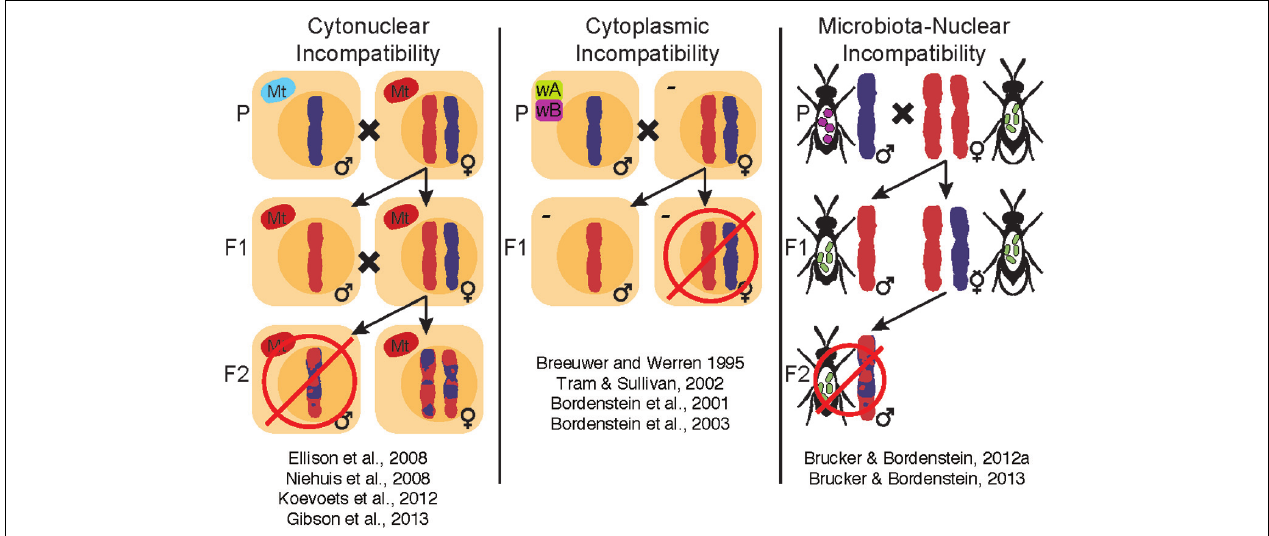
FIGURE 2 | Within the Nasonia clade, there are three published sources of hybrid incompatibilities: cytonuclear, cytoplasmic, and microbiota-nuclear incompatibilities. Cytonuclear incompatibilities, or negative interactions between mitochondria and the nuclear genome, are associated with lethality in F 2 males from younger interspecific crosses ( N. giraulti and N. longicornis ) and near complete lethality in older interspecific crosses ( N. vitripennis and N. giraulti or N. longicornis ). Hybrid lethality has some plasticity due to environmental factors (Koevoets et al., 2012), but clear cytonuclear incompatibilities that complicate development and gene regulation (Ellison et al., 2008; Niehuis et al., 2008; Koevoets et al., 2012; Gibson et al., 2013) have been genetically mapped across the Nasonia genomes. Cytoplasmic incompatibilities are a consequence of infection with different Wolbachia strains ( wA and wB ), which causes post-fertilization chromatin defects that result in inviable fertilized eggs (Bordenstein et al., 2001, 2003; Tram and Sullivan, 2002). Finally, microbiota-nuclear incompatibilities result from negative interactions between the microbiota and host genome and lead to hybrid lethality, altered microbial communities and innate immune regulation (Brucker and Bordenstein, 2013). The collective influences of these incompatibilities on Nasonia make it a powerful model for evolutionary and symbiotic studies of speciation and reproductive isolation. How these incompatibilities have evolved relative to each other is an important avenue for future